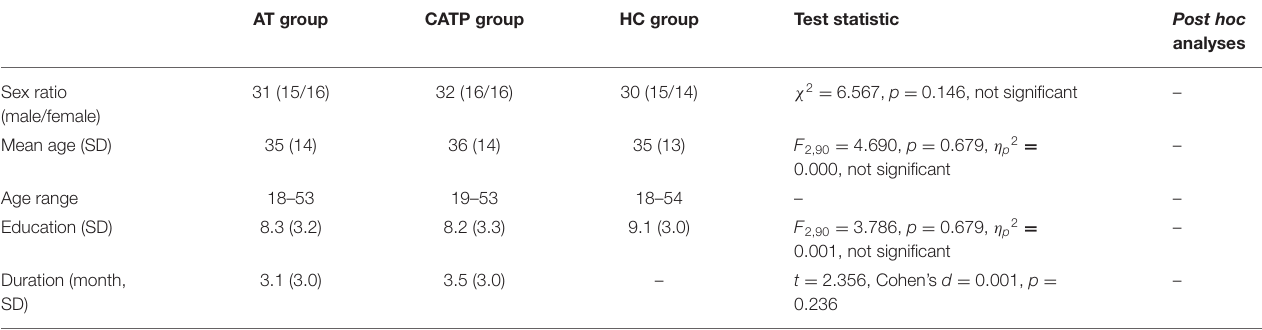
TABLE 1 | Demographic characteristics and clinical data of all participants. AT group CATP group HC group Test